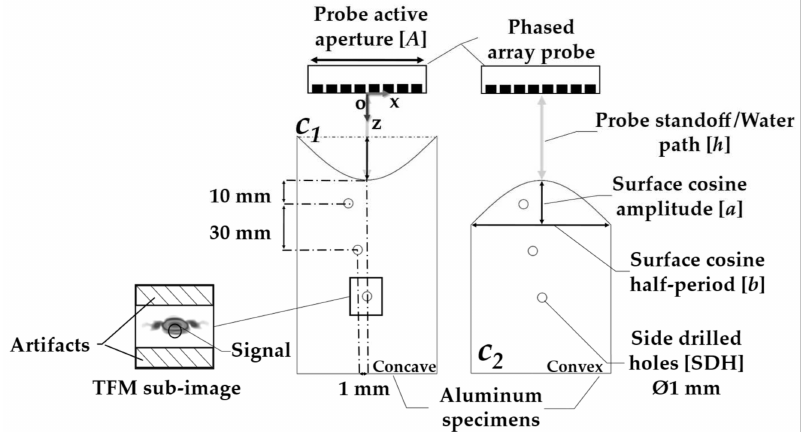
Figure 4. Schematic of the sinusoidal concave and convex specimens inspected by immersion phased array ultrasonic testing. The probe is centered relative to the surface. Three SDH are positioned inside the specimens and are analyzed by the TFM sub-image